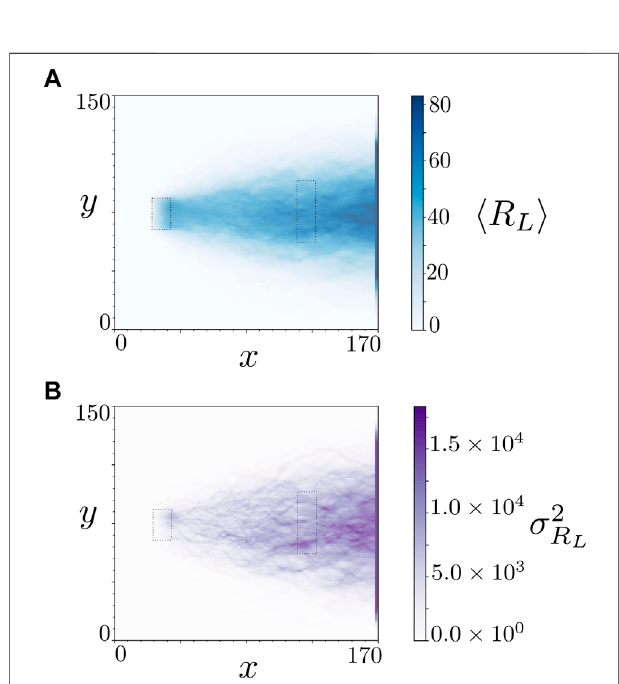
FIGURE 6 | Maps of the average loss of resilience (A) in the model domain, and its variance values (B) throughout the whole simulation time. The plot on the top shows how 〈 R L 〉 [d] evolves in space, expressing the amount of days necessaryfor each point in thedomain torecover upto areliable status. The amount of days associated with the different shades of blue are indicated by the values on the color bar on the right of the top plot. The plot at the bottom shows the values of the variance of R L , σ 2 R , as a measure of the L uncertainty related to the information given by the plot above.